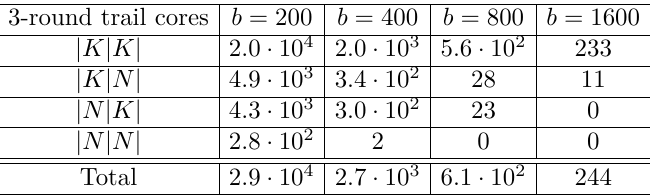
Table 8: Number of 3-round trail cores up to weight